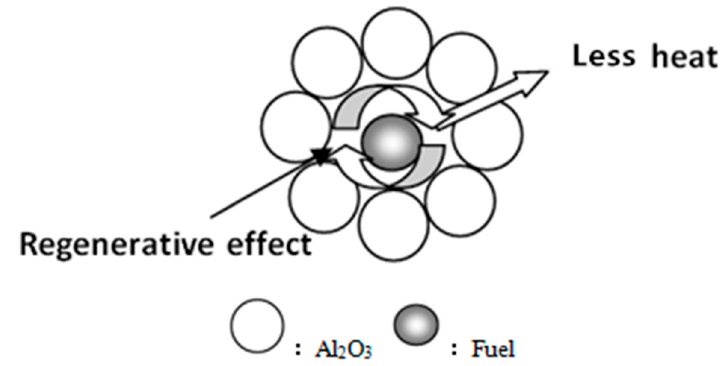
Figure 6. Thermal storage of quasi-particle sintering.